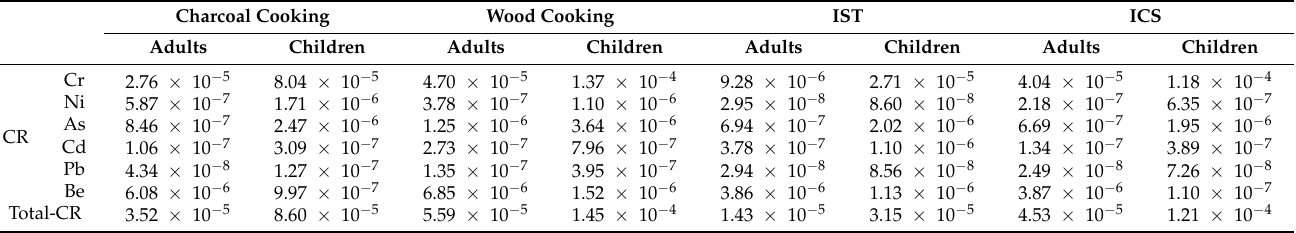
Table 3. Carcinogenic risks of toxic metals in different particulate matter samples collected by in situ samplings for adults and children. IST: insecticides; ICS: